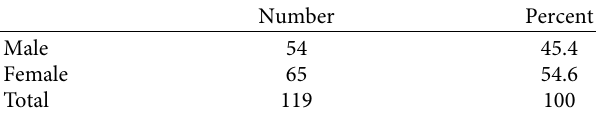
Table 1: Gender distribution of participants.